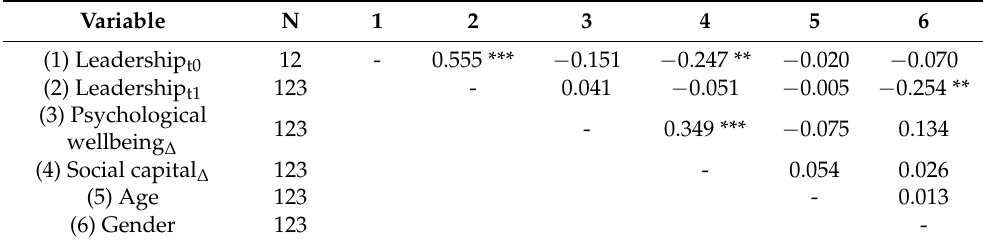
Table 2. Correlations between variables, model I.